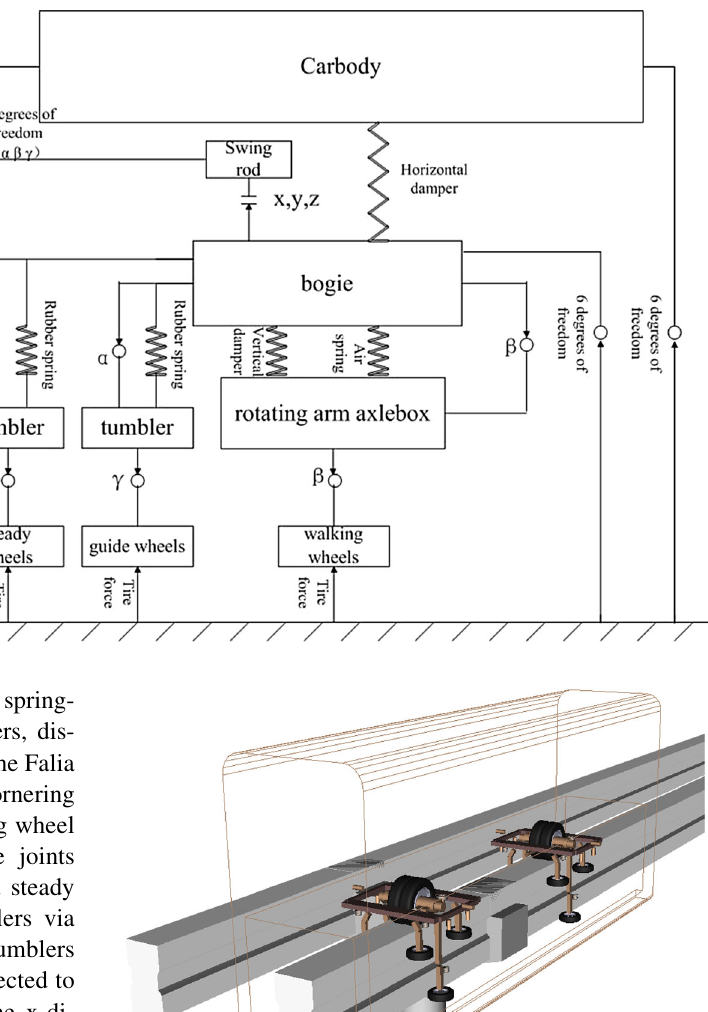
Fig. 7 Topological structure of